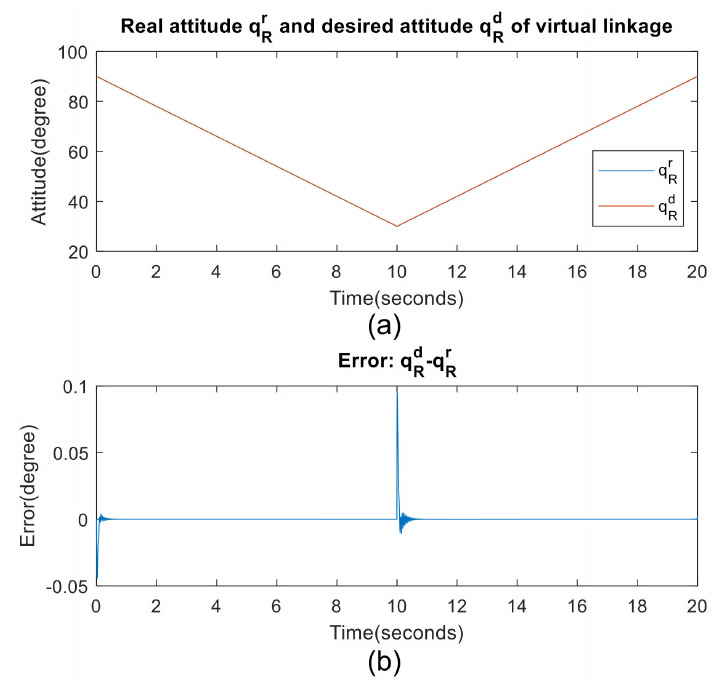
Figure 25. ( a ) Real and desired attitude of the virtual linkage; ( b ) error between real and desired attitude.